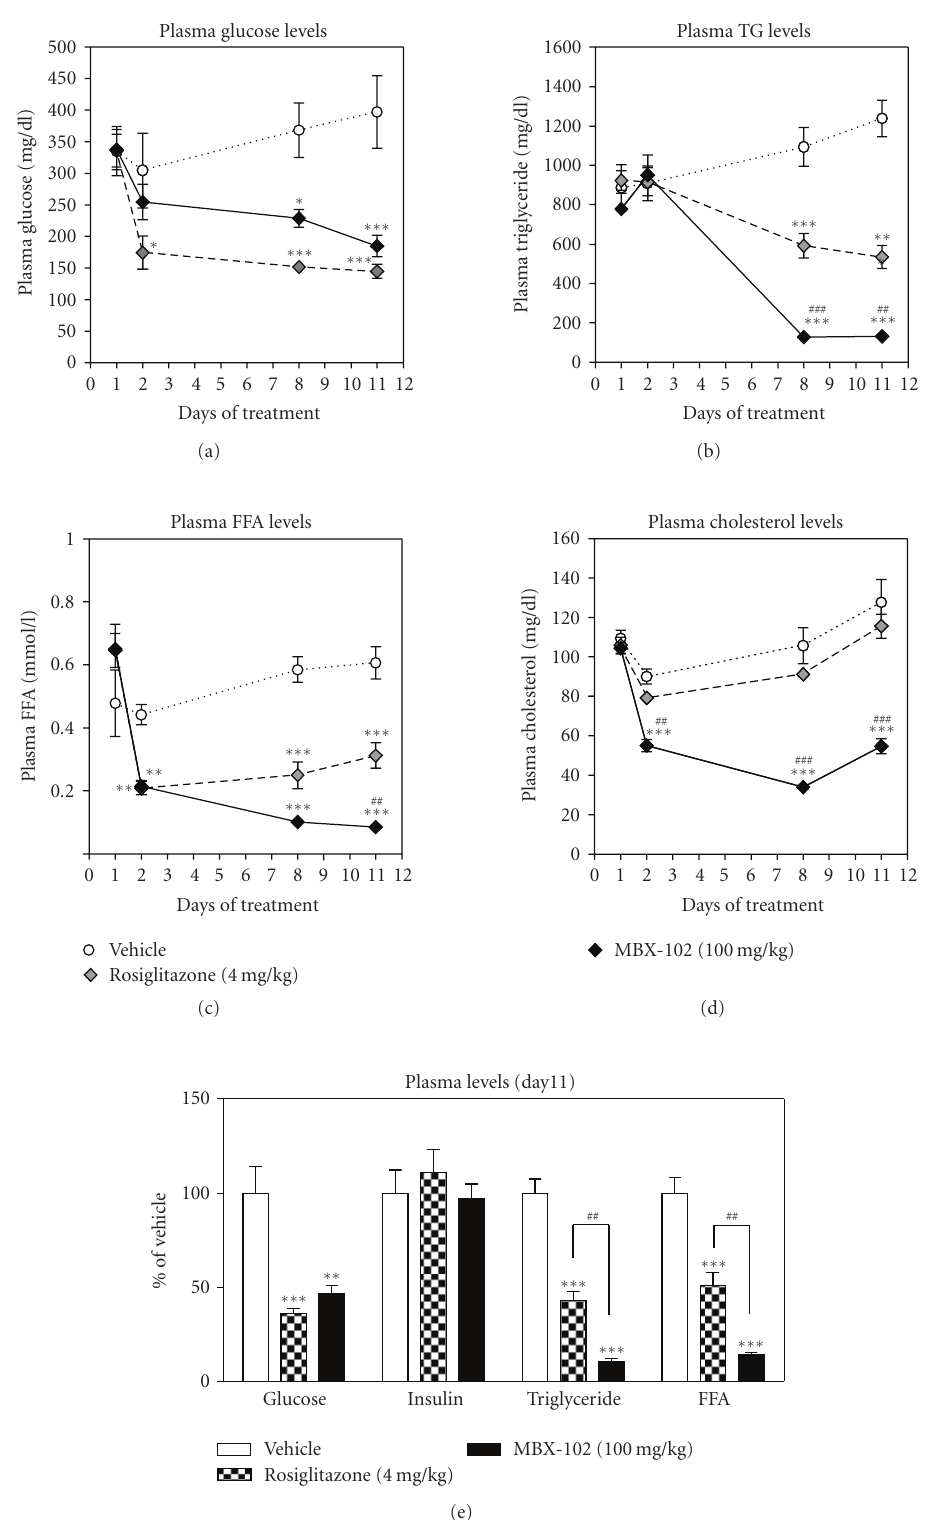
Figure 3: E ff ect of MBX-102 (100mg/kg) and rosiglitazone (4mg/kg) on fasting plasma glucose (a), triglycerides (b), FFA (c), and cholesterol (d) levels during the course of treatment of male ZDF rats. Values are plotted as mean ± SEM ( ∗ : P < . 05, ∗∗ : P < . 01, ∗∗∗ : P < . 001 versus ZDF vehicle; #: P < . 05, ##: P < . 01, ###: P < . 001 versus MBX-102-treated group, 2-way ANOVA followed by Bonferroni post tests). (e) Fasting plasma glucose, insulin, triglycerides, and FFA levels on day 11. Values are plotted as mean percentage of vehicle ± SEM (NS: P > . 05, ∗ : P < . 05, ∗∗ : P < . 01, ∗∗∗ : P < . 001 versus ZDF vehicle, ##: P < . 01 versus MBX-102-treated group, 1-way ANOVA and Tukey’s multiple comparison